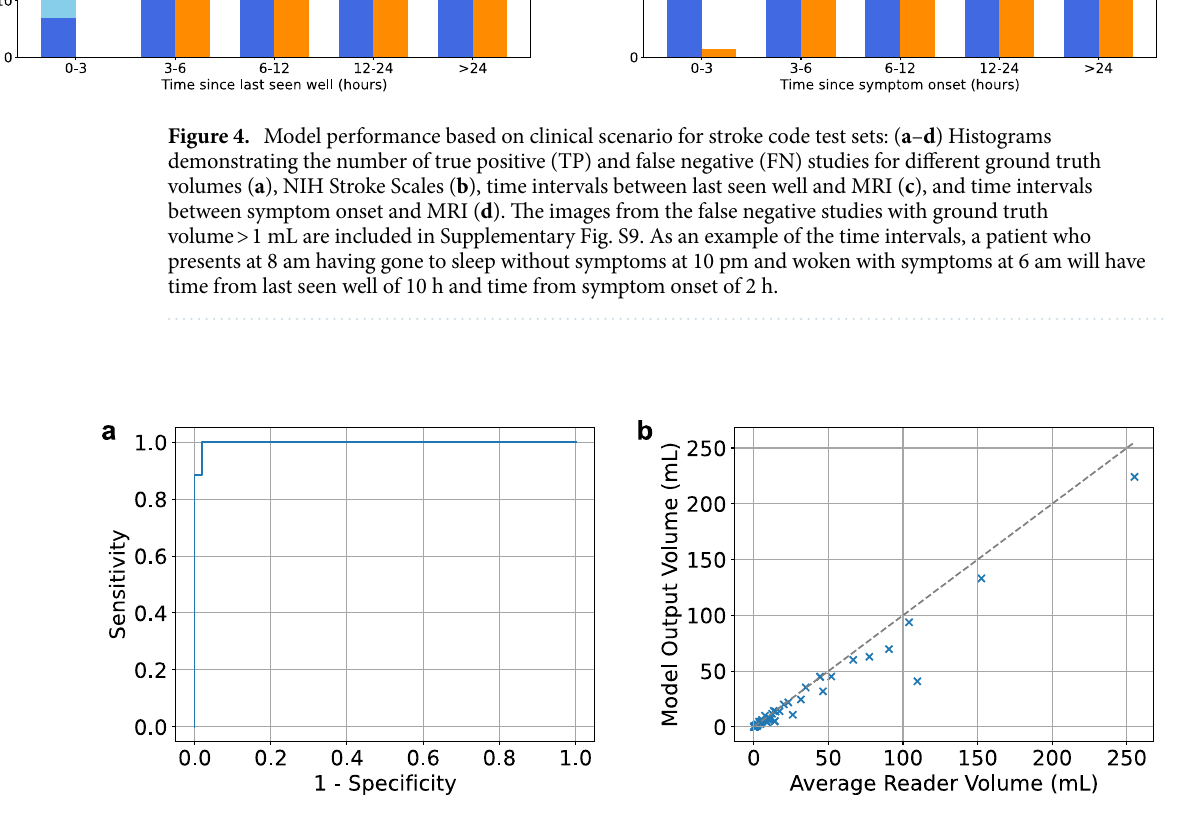
Figure 5. Model performance on international test set: ( a ) Receiver operating characteristic curve for the international test set. ( b ) Volume plot comparing averaged reader volume with model output volume for the international test